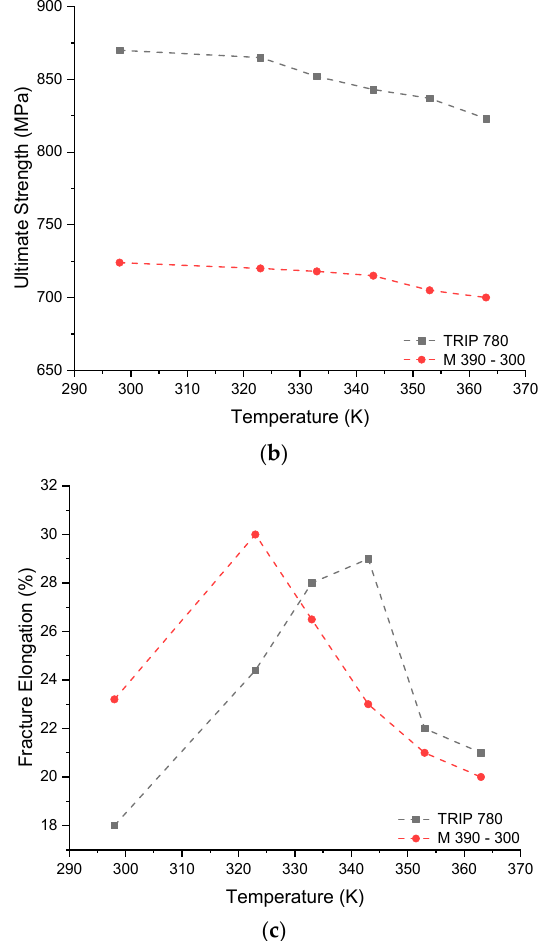
Figure 14. Effect of temperature on mechanical properties of M390-300 sample. ( a ) Yield stress; ( b ) UTS; ( c ) Fracture elongation.